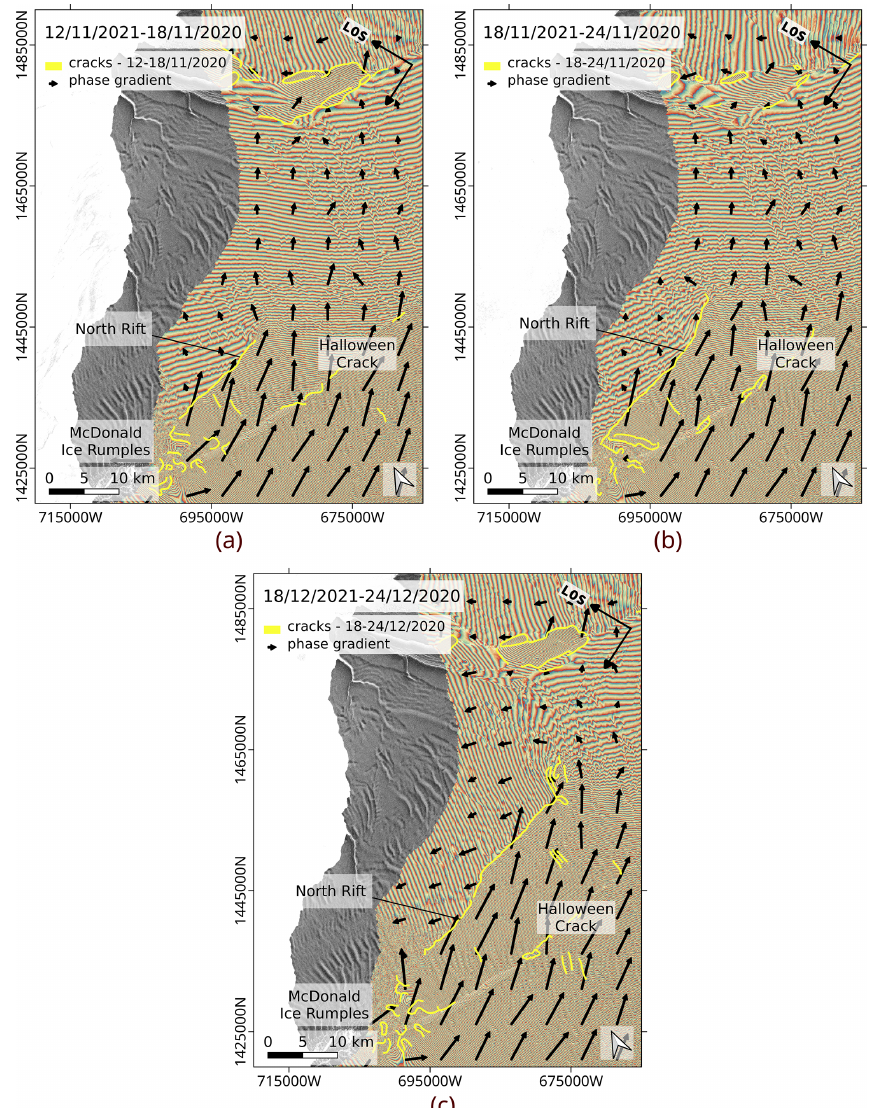
Figure 8. Sentinel-1 repeat-pass interferograms on BIS, overlaid with the cracks delineated from the phase gradient magnitude (yellow lines). The phase gradient is pictured by the vector field. (a) 12–18 November 2020. (b) 18–24 November 2020. (c) 18–24 December 2020. The comparison of the interferograms shows a rapid propagation of the North Rift between 18 and 24 November 2020. In December 2020, the crack almost reached the Stancomb–Wills Chasm. As the crack propagates, the phase gradient intensifies and changes direction on both sides of the